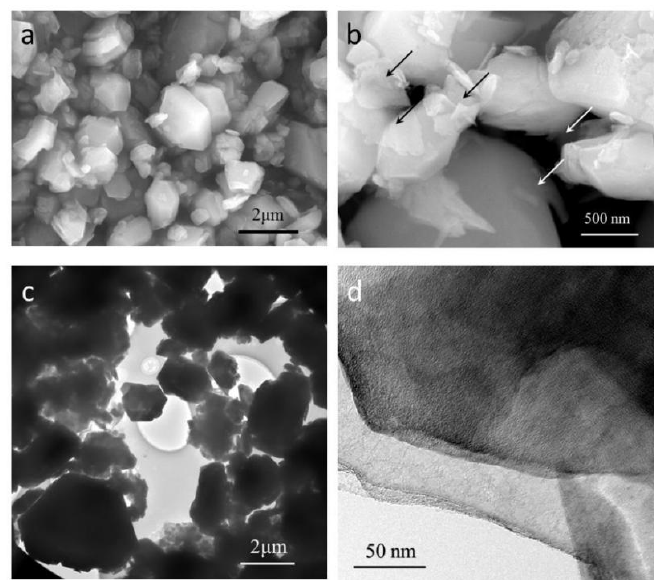
Figure 3. SEM micrographs of ( a ) ATH and ( b ) ATH/GNP; TEM micrographs of ( c , d ) ATH/GNP.